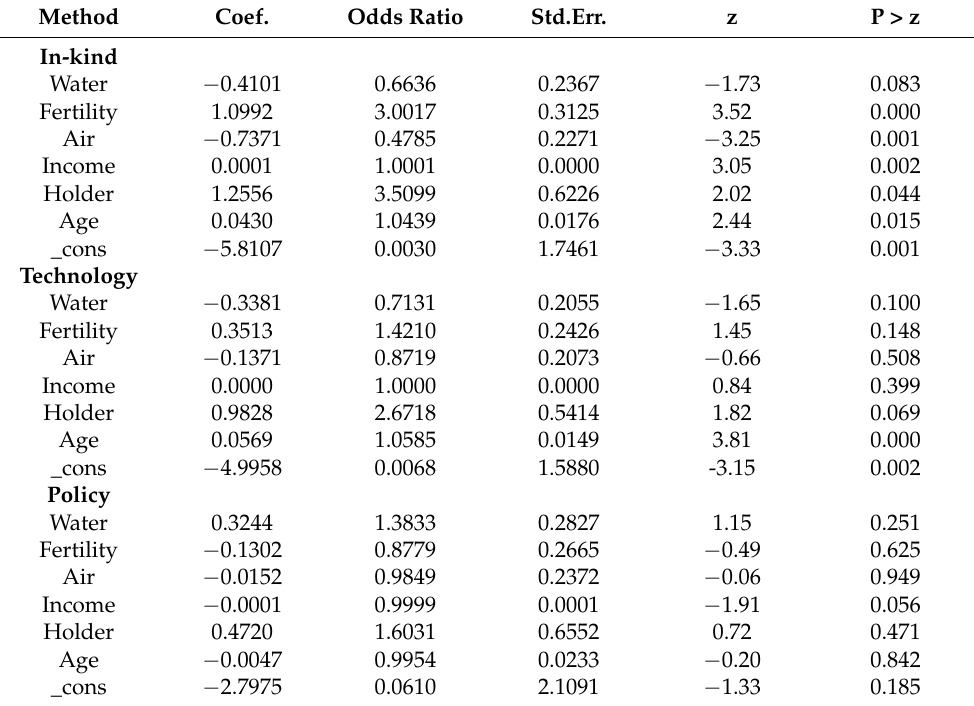
Table 2. Results of MNL model on citizen questionnaire